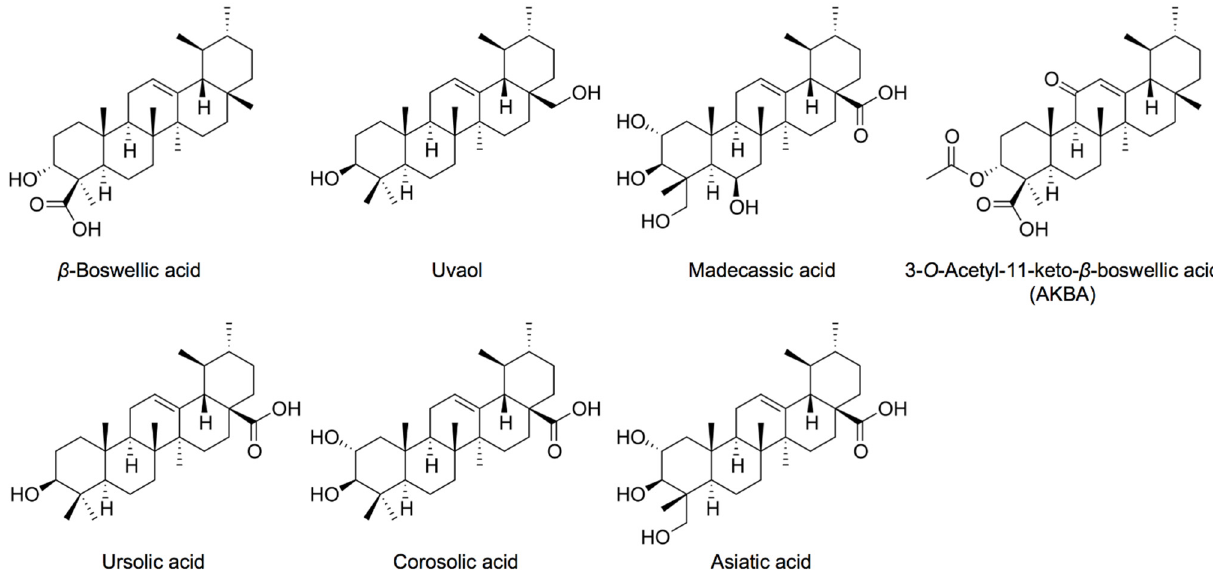
Figure 1. Structures of ursane-type pentacyclic triterpenoids.